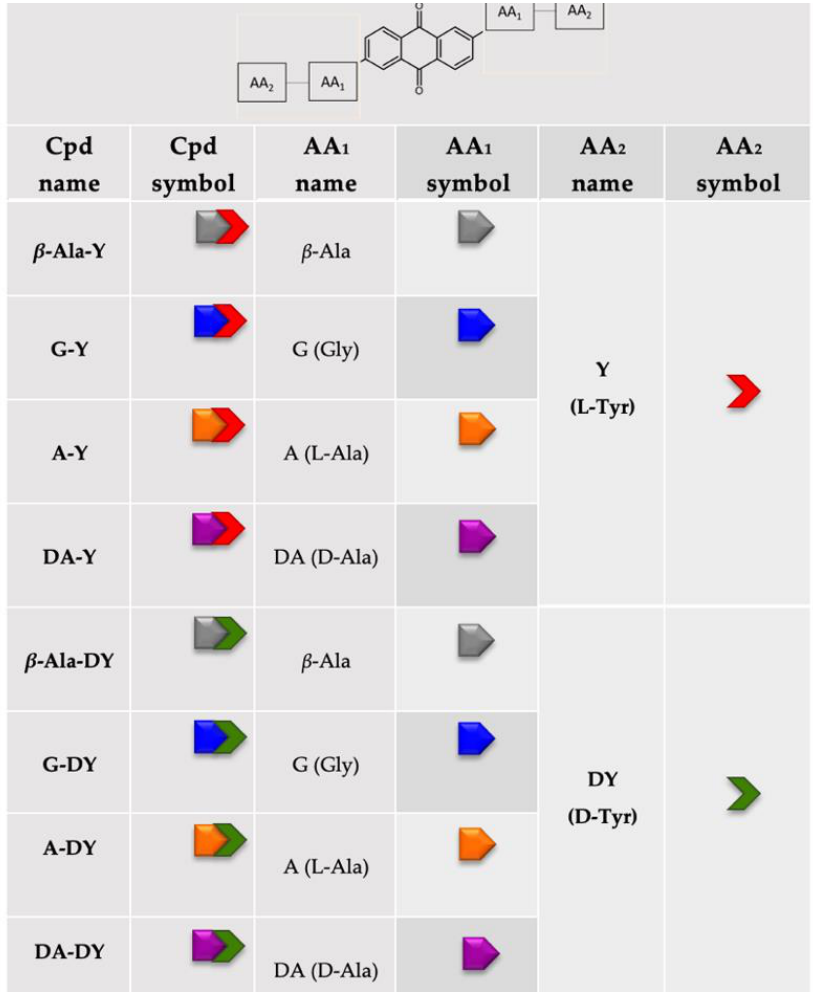
Figure 2. Schematic structures of the L -Tyr (Y) and D -Tyr (DY) series of 2,6-dipeptidyl − anthraquinone conjugates included in the study. The different amino acids constituting the peptidyl side chains (AA 1 and AA 2 ) are indicated by specific symbols and colours.